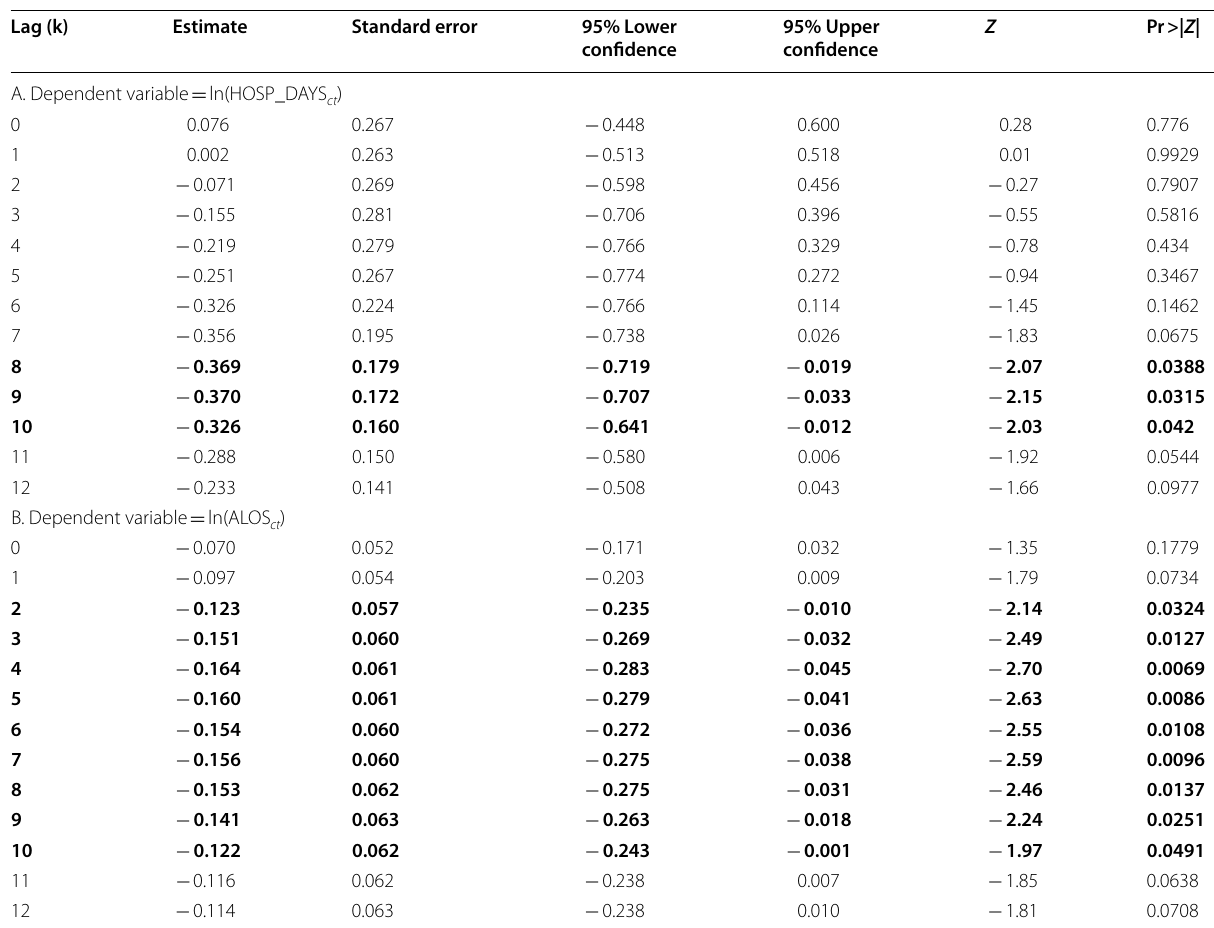
Table 4 Estimates of β from 2-way fixed-effects hospital utilization models [Eq. (3)] k